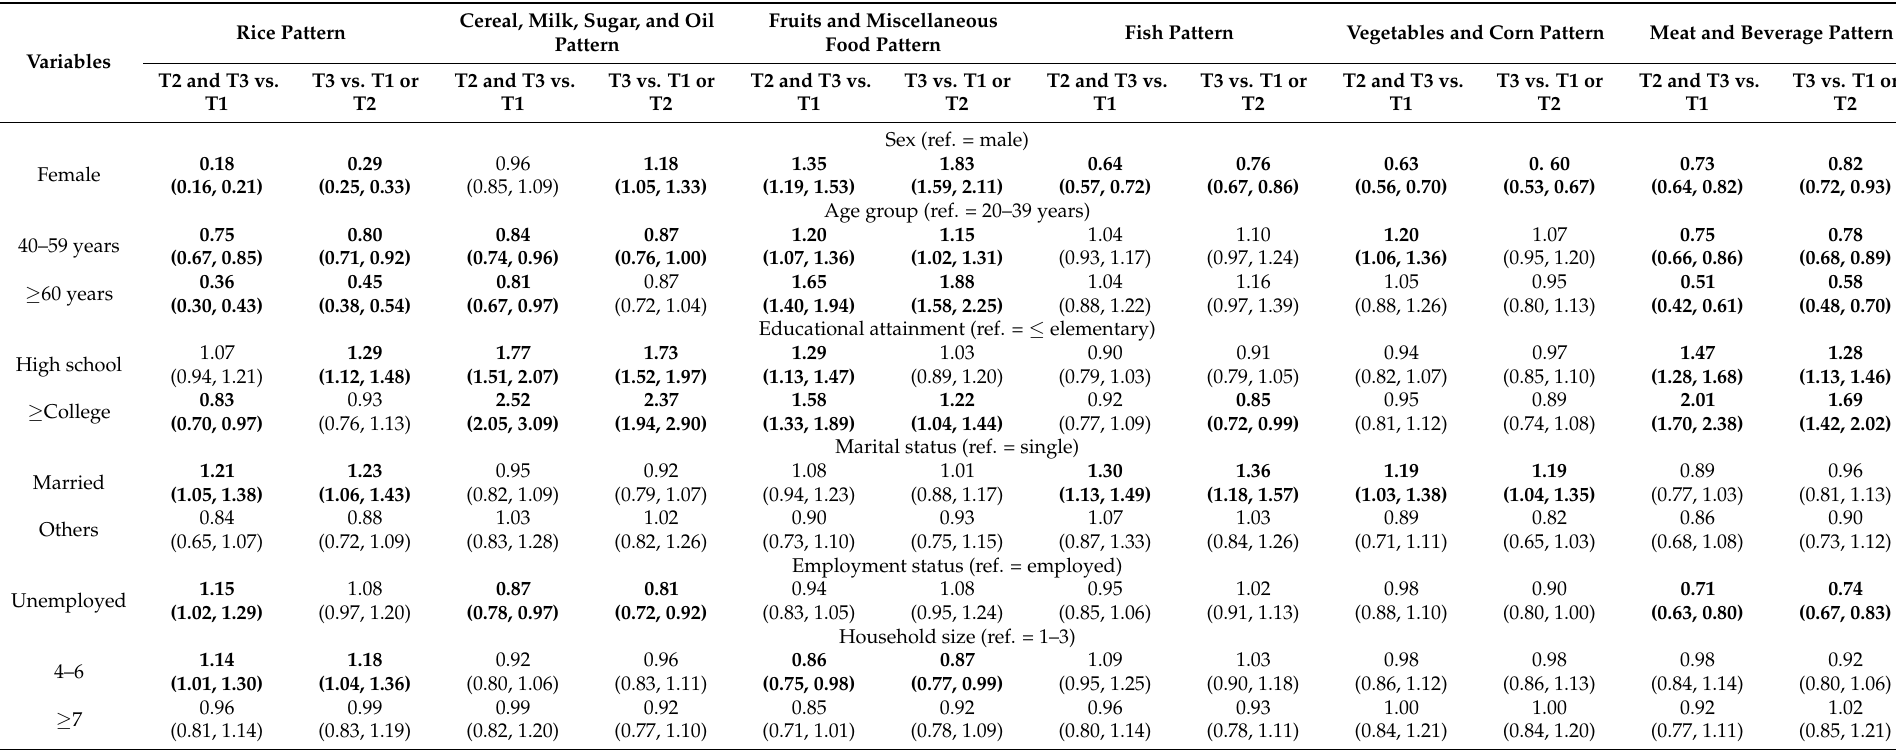
Table 4. Sociodemographic and lifestyle factors associated with dietary patterns analyzed by generalized ordered logistic regression 1